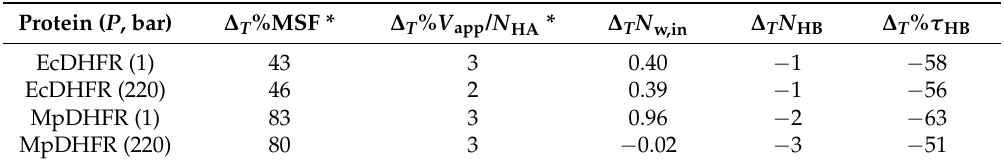
Table 2. Changes of average properties for EcDHFR and MpDHFR with temperature at constant pressure P , where ∆ T indicates a change from 279 to 310 K and percentages are with respect to the 279 K value. Protein ( P , bar) ∆ T %MSF * ∆ T % V app /N HA * ∆ T N w,in ∆ T N HB